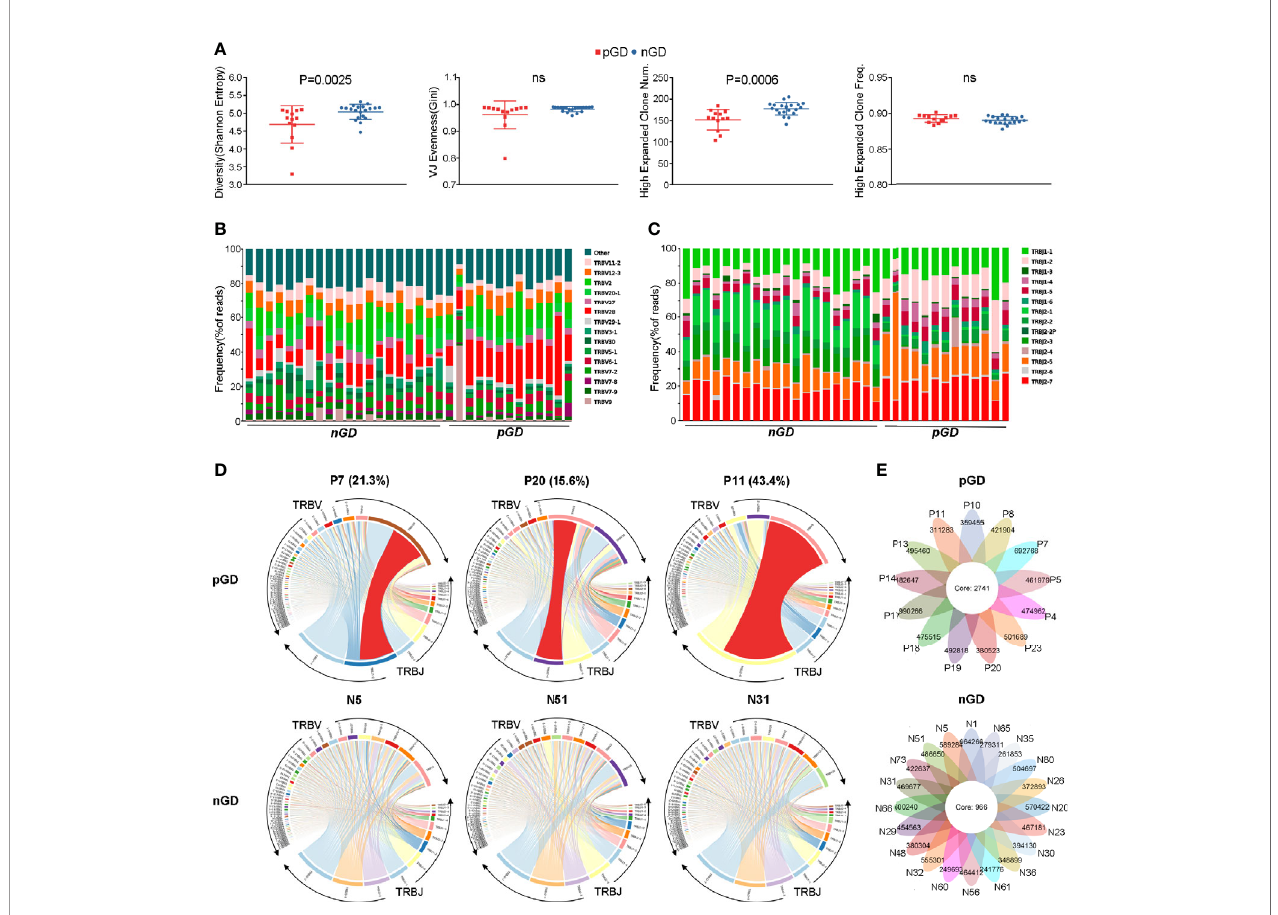
FIGURE 2 | Restricted TCR clonetype were revealed in pGD compared with nGD patients. (A) Whisker plots showed Shannon entropy, Gini, high expanded clone number, as well as high expanded clone frequency in pGD patients (red, N = 13) compared with nGD patients (blue, N = 20). Data were exhibited as mean with SD with individual values. (B, C) TCR (B) V segment and (C) J segment frequencies of reads in pGD patients (N = 13) compared to nGD patients (N = 20). Columns represent individual samples. The colors in the bars within each column indicate different V and J segments, and were denoted on the right. (D) TRBV and TRBJ gene segment usage and V-J recombination were illustrated by circos plots in sample pGD patients (upper) represented by P7, P20, P11 and nGD patients (bottom) represented by N5, N51, N31. The TRBV and TRBJ genes were clockwise arranged in the order of their frequency from low to high. A VJ recombination was illustrated by colored curved paths whose thickness represents their frequencies in TCR repertoires. (E) Flower plots presented the amount of the overlap (core) and individual (petal) in TCR clonotypes in pGD patients (upper, N = 13) and nGD patients (bottom, N = 20), respectively. Freq, frequency; pGD, persistent Graves ’ disease; nGD, newly diagnosed Graves ’ disease; SD, standard deviation; TCR, T cell